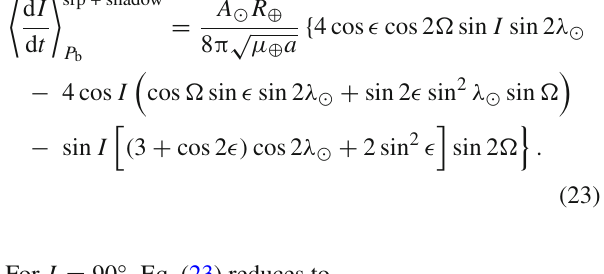
Fig. 5 obtained for the mass of the existing LAGEOS satellite and by varying the satellite’s electric charge within − 100 × 10 − 11 C ≤ Q ≤ − 1 × 10 − 11 C [67]. Equation (33) of Abdel-Aziz and Khalil [1] shows that, for polar orbits, the inclination is not affected by electric forces of dipolar